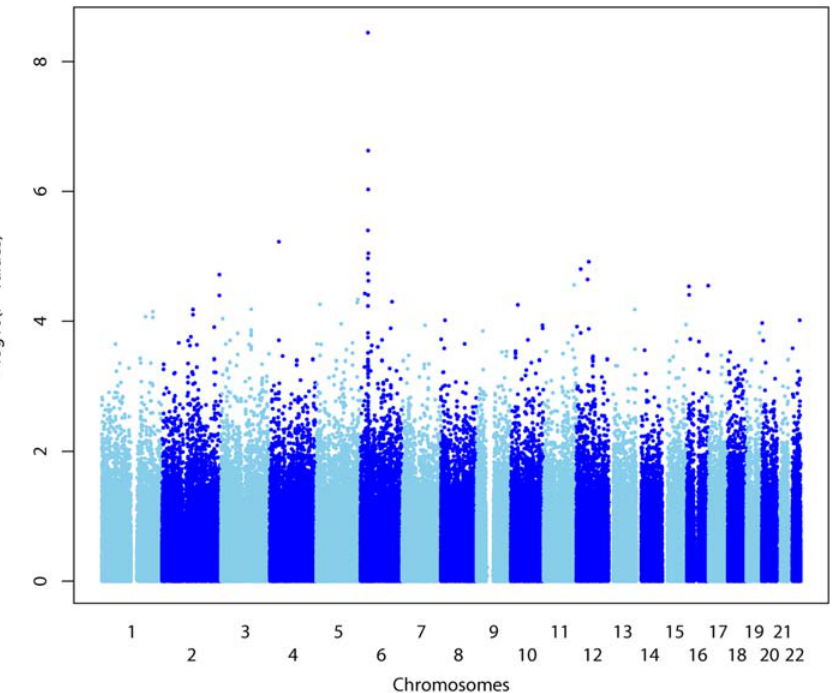
Figure 1. Genome wide association (GWA) study for plasma HIV-RNA levels in the ANRS PRIMO cohort. Negative log 10 (P)-values for the score test for genome-wide association across the genome ordered from 1pter to 22qter. Adjacent chromosomes are shown in light blue and dark blue. The spacing between SNPs does not reflect actual physical distances. The false discovery rate was calculated based on a stratified approach (by chromosome) leading to chromosome-specific thresholds.